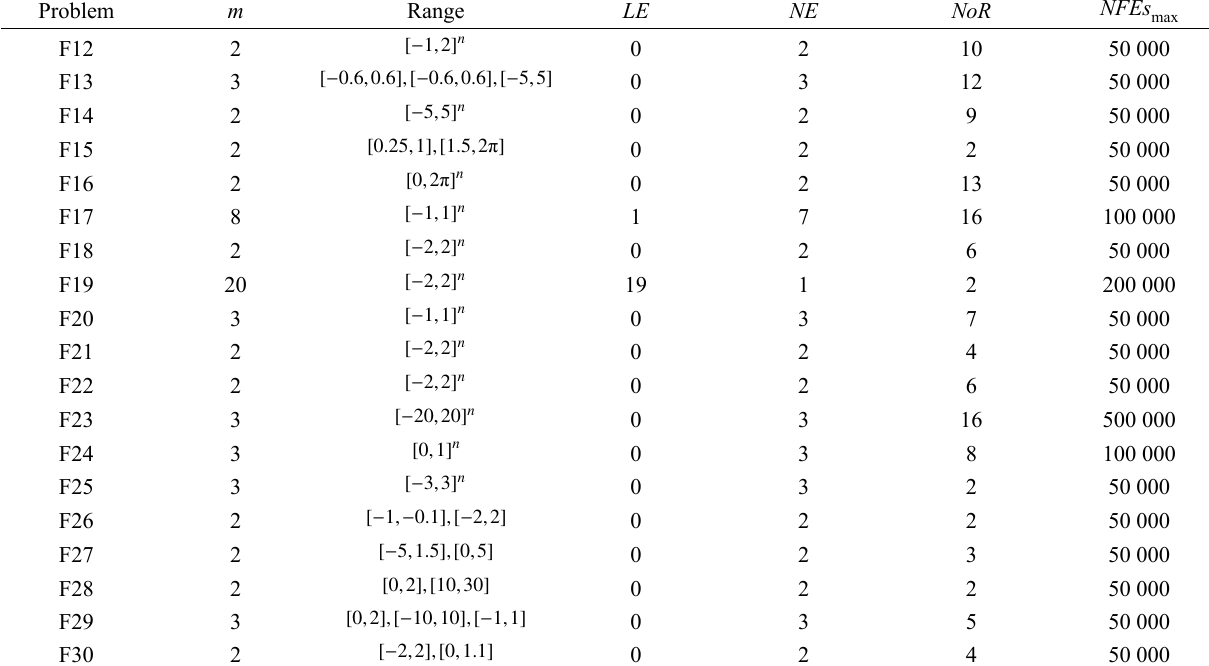
Table A1 Brief information of the test problems.